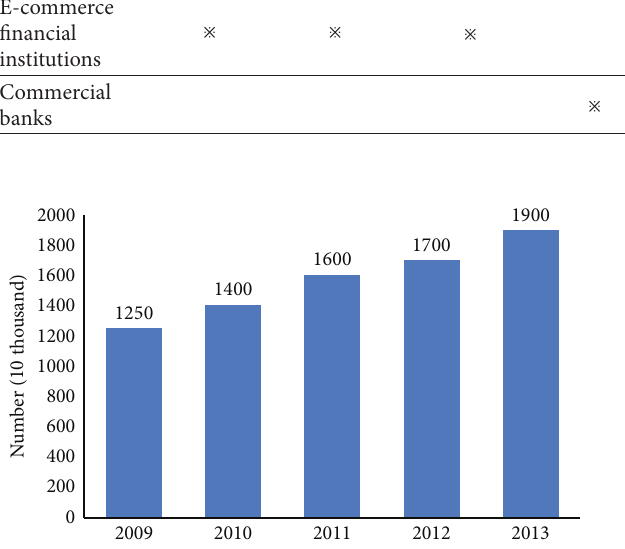
Figure 1: The growth trend of MSMEs with e-commerce platform (2009–2013). Data source: China E-Commerce Research Center